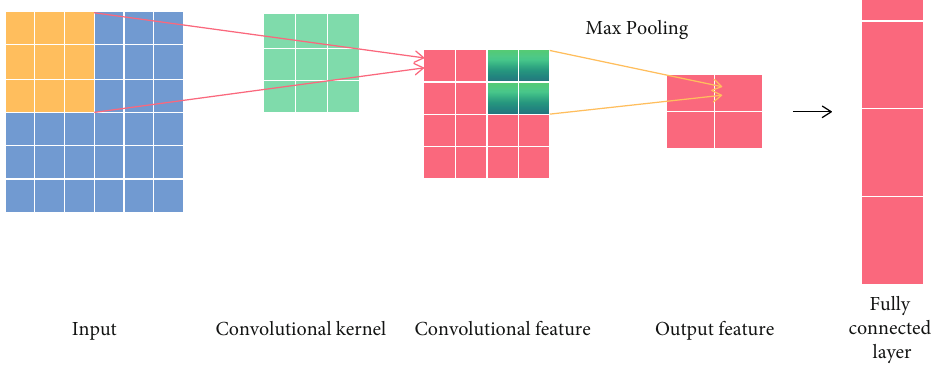
Figure 1: The structure of CNN and its unrolled